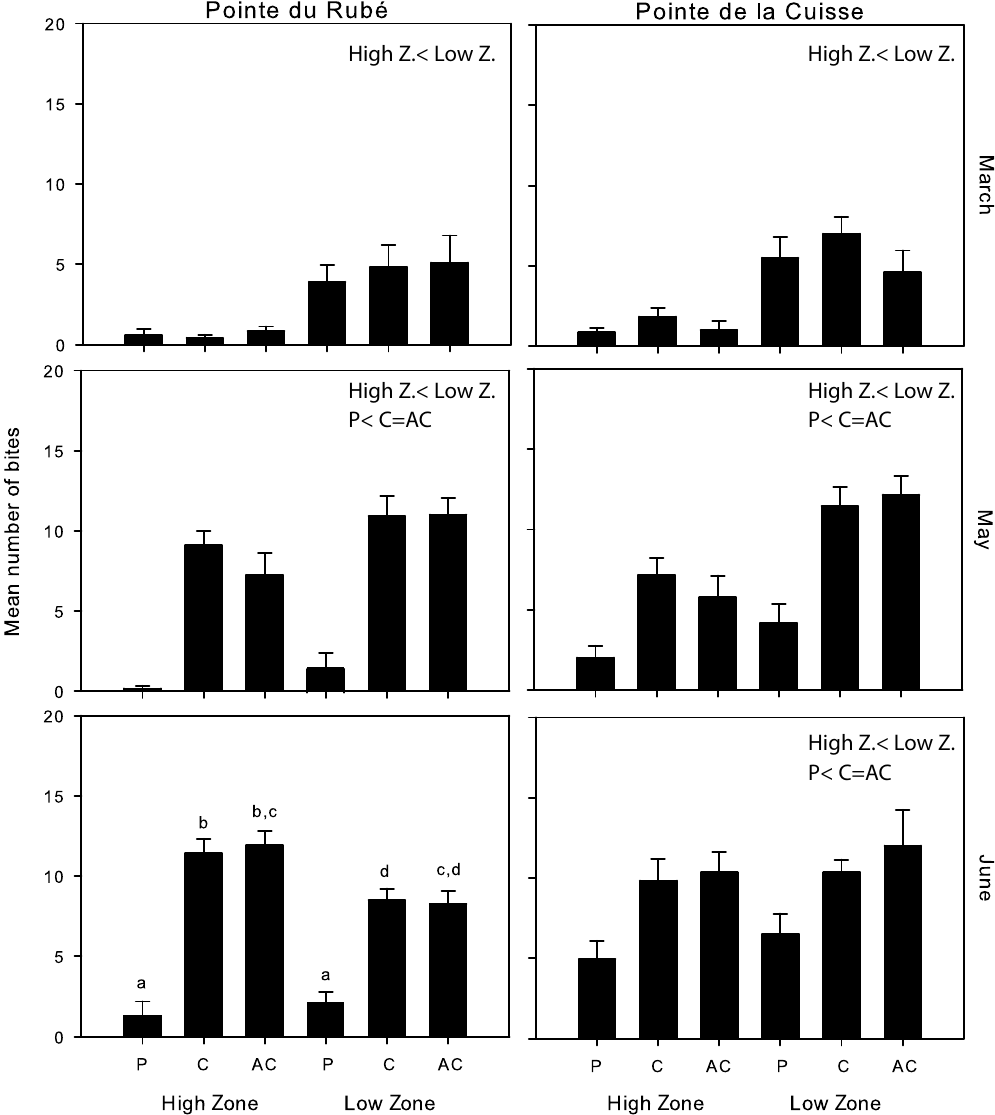
Figure 4. Fish herbivory. Number of fish bites/12.5 cm 2 (mean plus SE calculated on all plots, n = 4) for each zone (High and Low) and treatment in the different months and at both sites. P: protected; C: control plots; AC: artefact control. The results of the pairwise tests on the factors Treatment and Zone are reported above the graph (see Table 1 and Supplementary Tables S1.1–2 for more details). Letters above the bars in June at Cap du Rubé indicate significant differences of the pairwise-tests on the interaction TrxZo (Table 1 and Supplementary Table S.1.1 for more